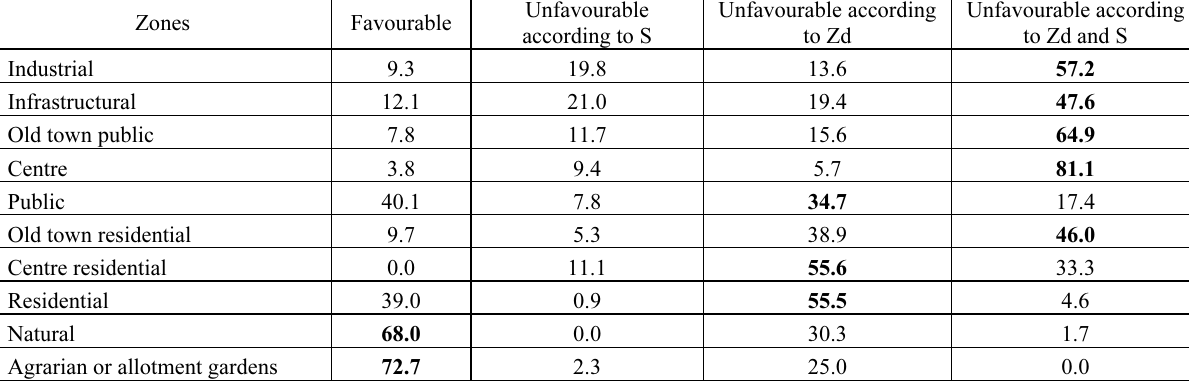
Unfavourable Unfavourable according Unfavourable according according to S to Zd to Zd and S